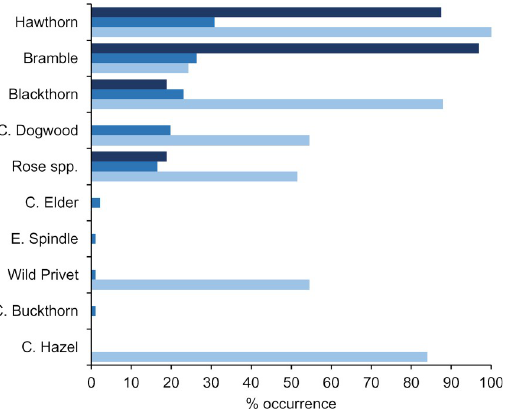
Fig 5. Shrub species frequency. The percentage occurrence of shrub species in sampling sites, comprising 32 quadrats of 1 m 2 in the New Wilderness (dark blue bars), 91 quadrats of 1 m 2 in the Old Wilderness (mid blue bars) and 33 sample plots of 0.1 ha in Monks Wood (pale blue